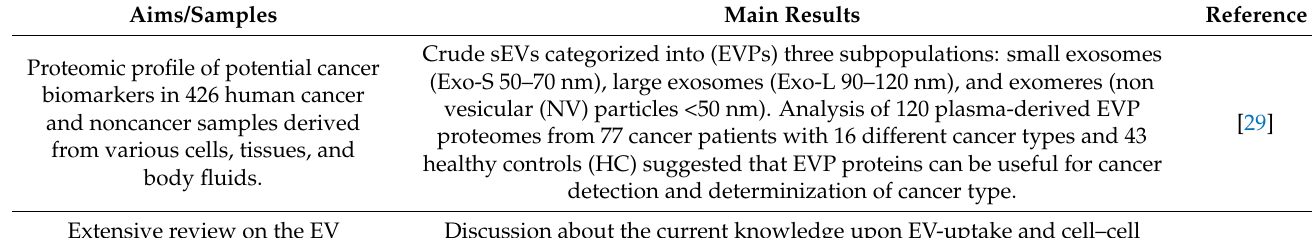
Table 3. Preclinical studies about the circulating tumor-derived EV-gDNA as a potential cancer biomarker